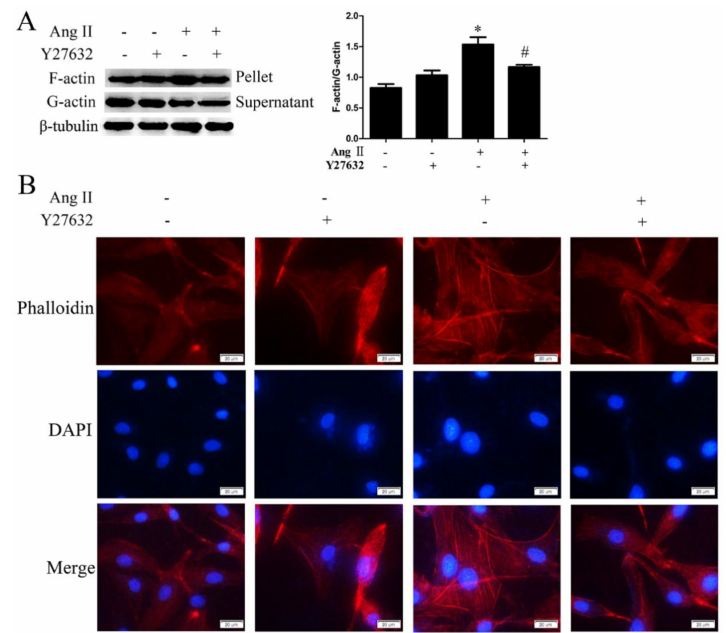
Figure 8. The effects of Y27632 pretreatment on F-actin polymerization in Ang II-treated HA-VSMCs. Cells were pretreated with Y27632 (20 µ M) for 30 min and then exposed to 100 nM Ang II for 24 h. Untreated cells were used as the control. ( A ) The ratio of F-actin to G-actin analyzed by G-actin / F-actin In Vivo Assay Kit and Western blot analysis. Histogram shows the ratio of F-actin to G-actin. * p < 0.05 vs. the control group; # p < 0.05 vs. the Ang II-treated group ( n = 3). ( B ) Phalloidin conjugates for staining F-actin filaments.